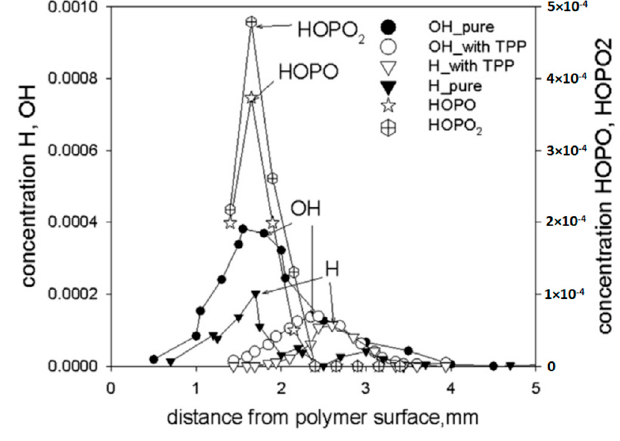
Figure 21. The concentration profiles of H, OH, HOPO, and HOPO 2 in the flames of UHMWPE without and with 5 wt% TPP.